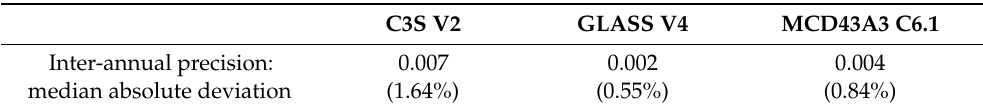
Table 9. Inter-annual precision indicator (median absolute deviation between two consecutive years) of C3S V2, GLASS V4, and MCD43A3 C6.1 products. Evaluation for total shortwave black-sky albedo retrievals over LANDVAL sites in the 2001–2005 period considering all pixels.